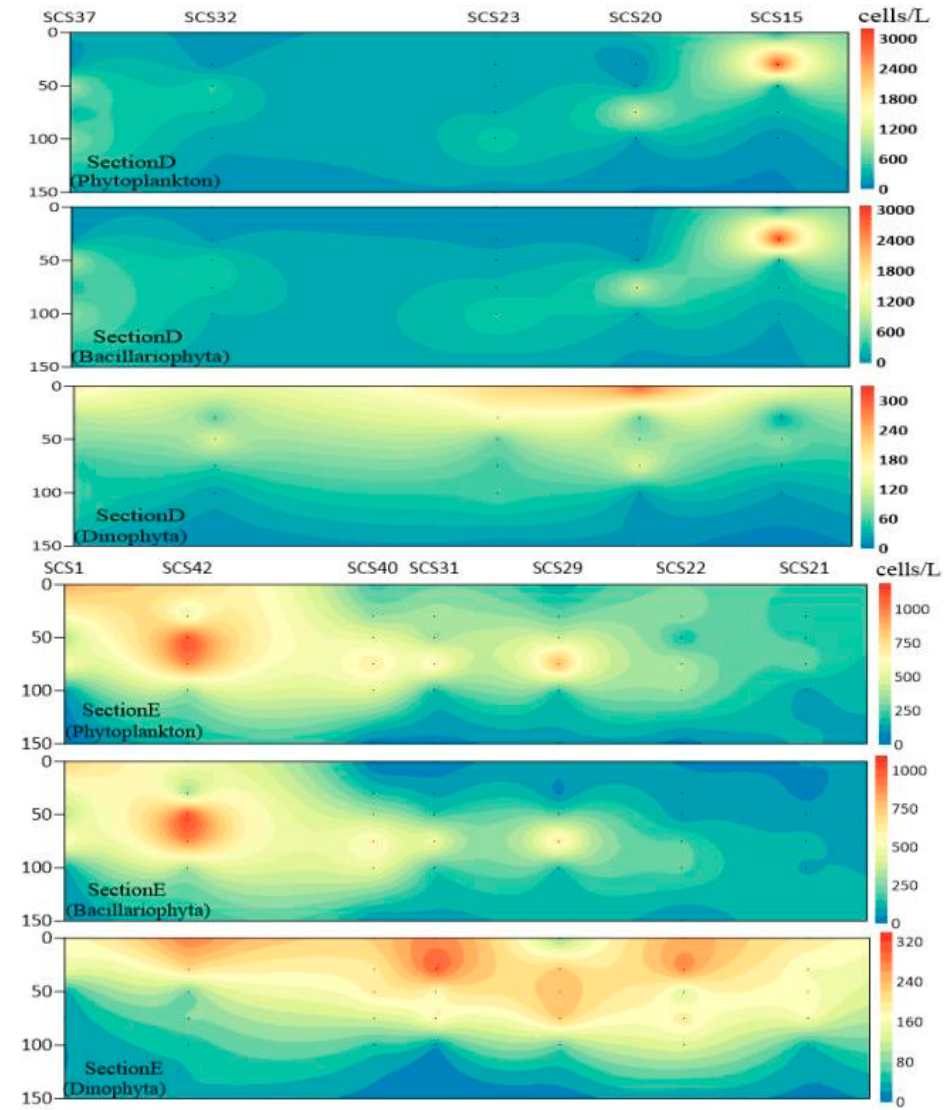
Figure 4. Vertical distribution of cell abundance in Transects A, B, C, D, and E in the northern South China Sea.